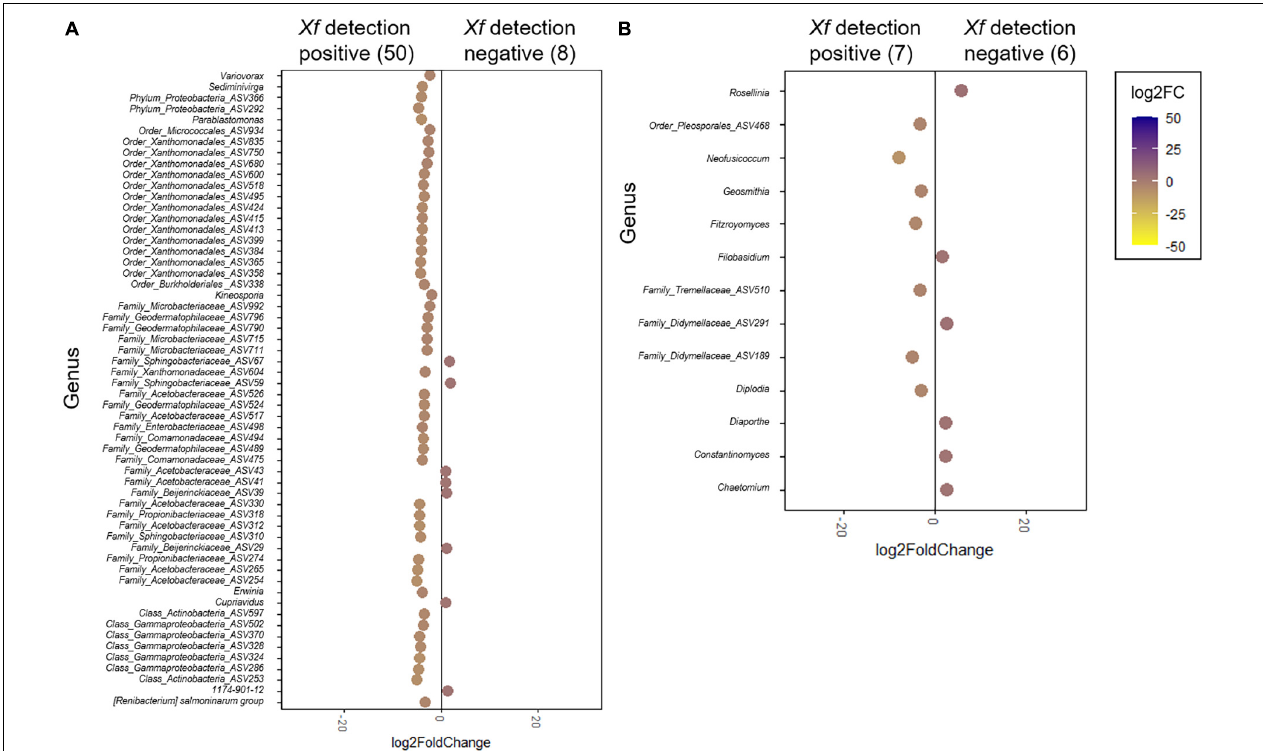
FIGURE 7 | DESeq2 analysis of differentially enriched bacterial (A) and fungal (B) genera present in the xylem of Xylella fastidiosa -qPCR negative and positive almond trees sampled in different orchards in Alicante province. The color scale bar indicates log2 fold change. Only significant genera ( p < 0.05) are